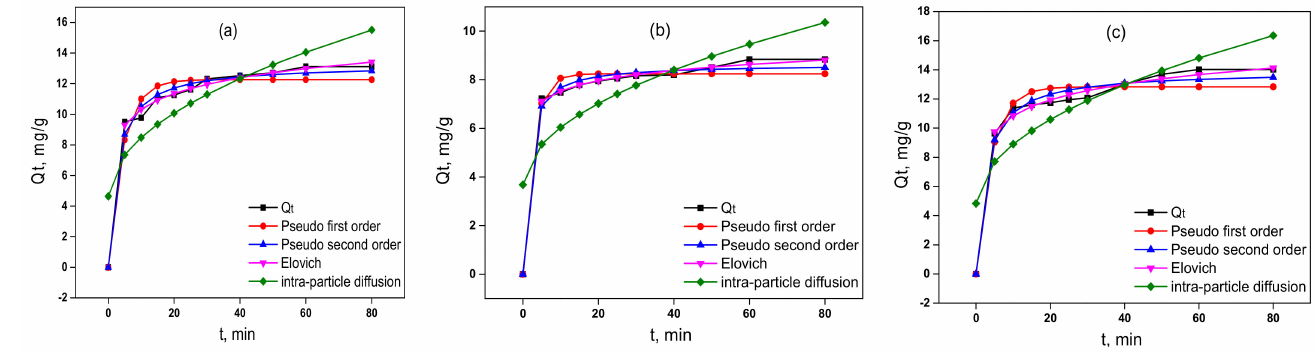
Figure 8. Graphs of nonlinear kinetics models for IC adsorption by RBS ( a ), BST1 ( b ) and BST2 ( c ).